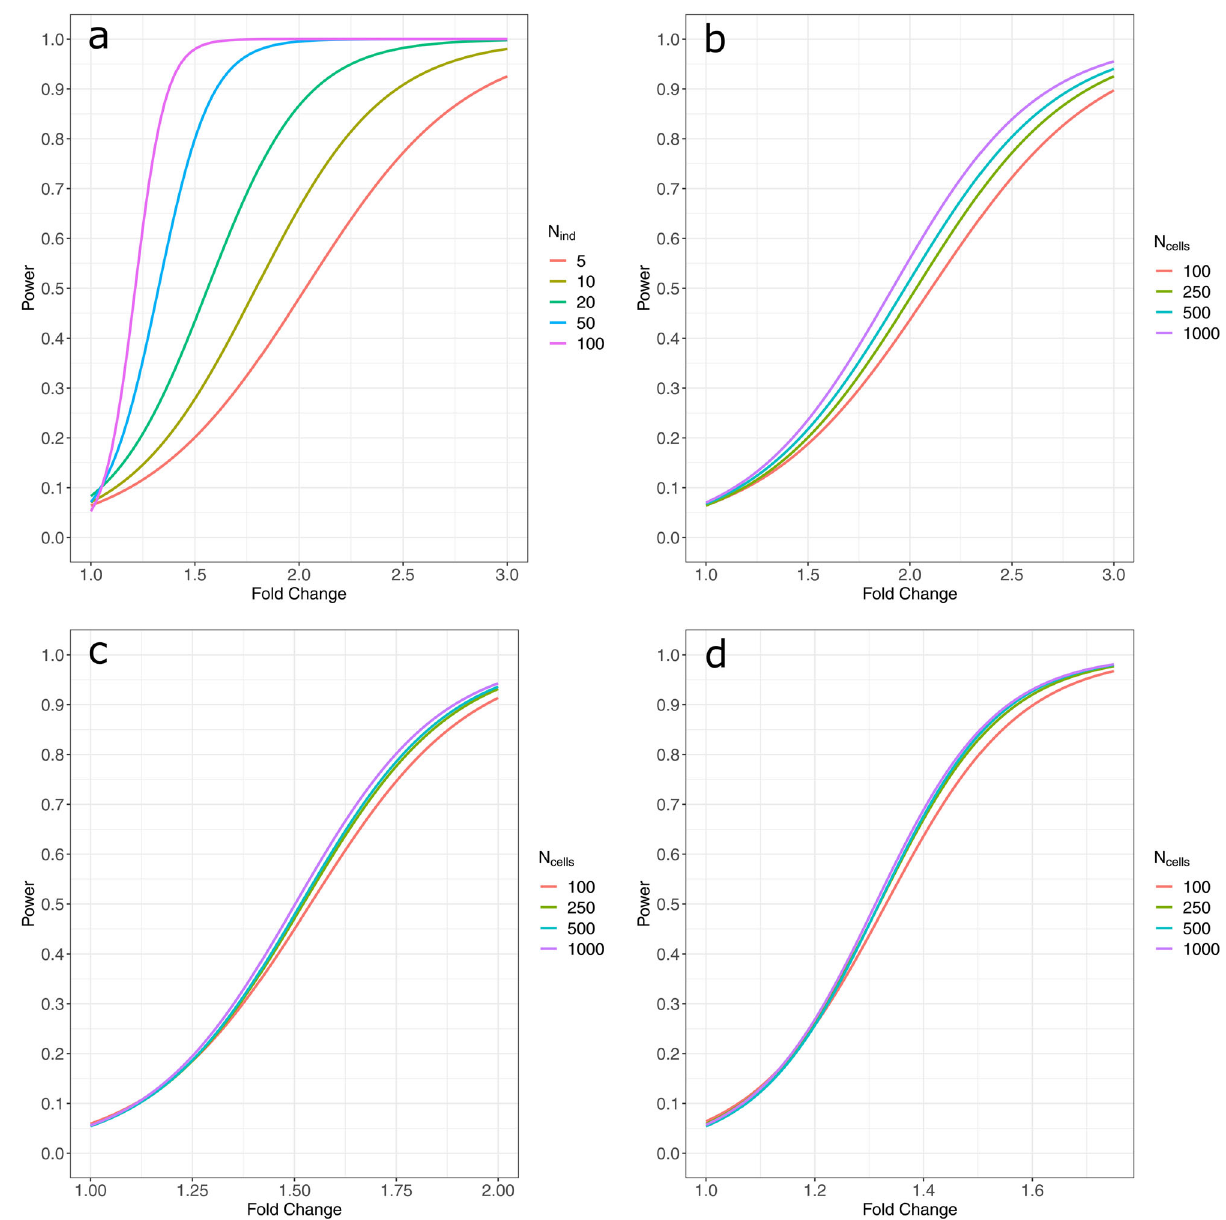
Fig. 3 Power calculations using MAST with a random effect for the individual. Power curves for various, but likely, single-cell scenarios using MAST with a random effect for individual. Fold-change is simulated by multiplying the global mean gene expression values by the fold-change value for one group. All power is computed at α = 0.05. a Differences in power when sample sizes range between 5 individuals per group to 100 when the number of cells per individual is held constant at 250. b – d Differences in power when increasing the number of cells per individual (100, 250, 500, 1000) for 10, 20, and 50 individuals per group, respectively. Additional power curves are supplied in the supplementary